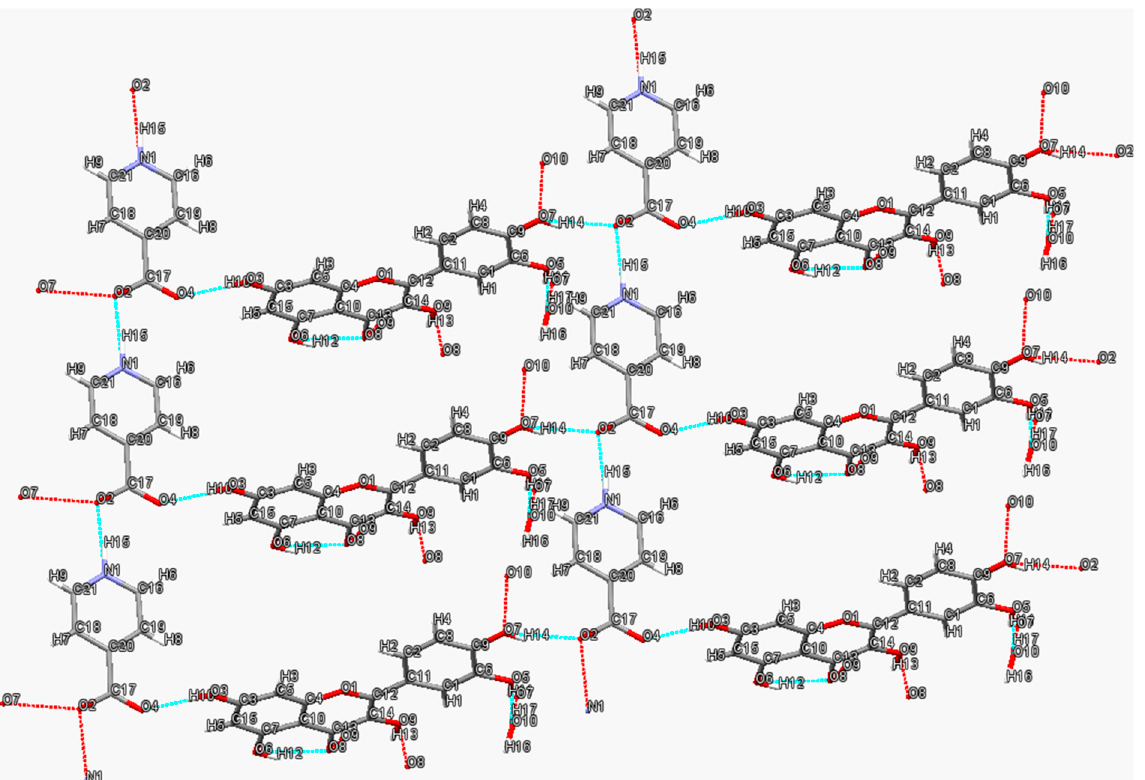
Figure 3. Two-dimensional hydrogen bonding network in quercetin-isonicotinic acid monohydrate. Hydrogen bonds are represented by blue dashed lines. Red dashed lines indicate further interactions with other molecules not shown.